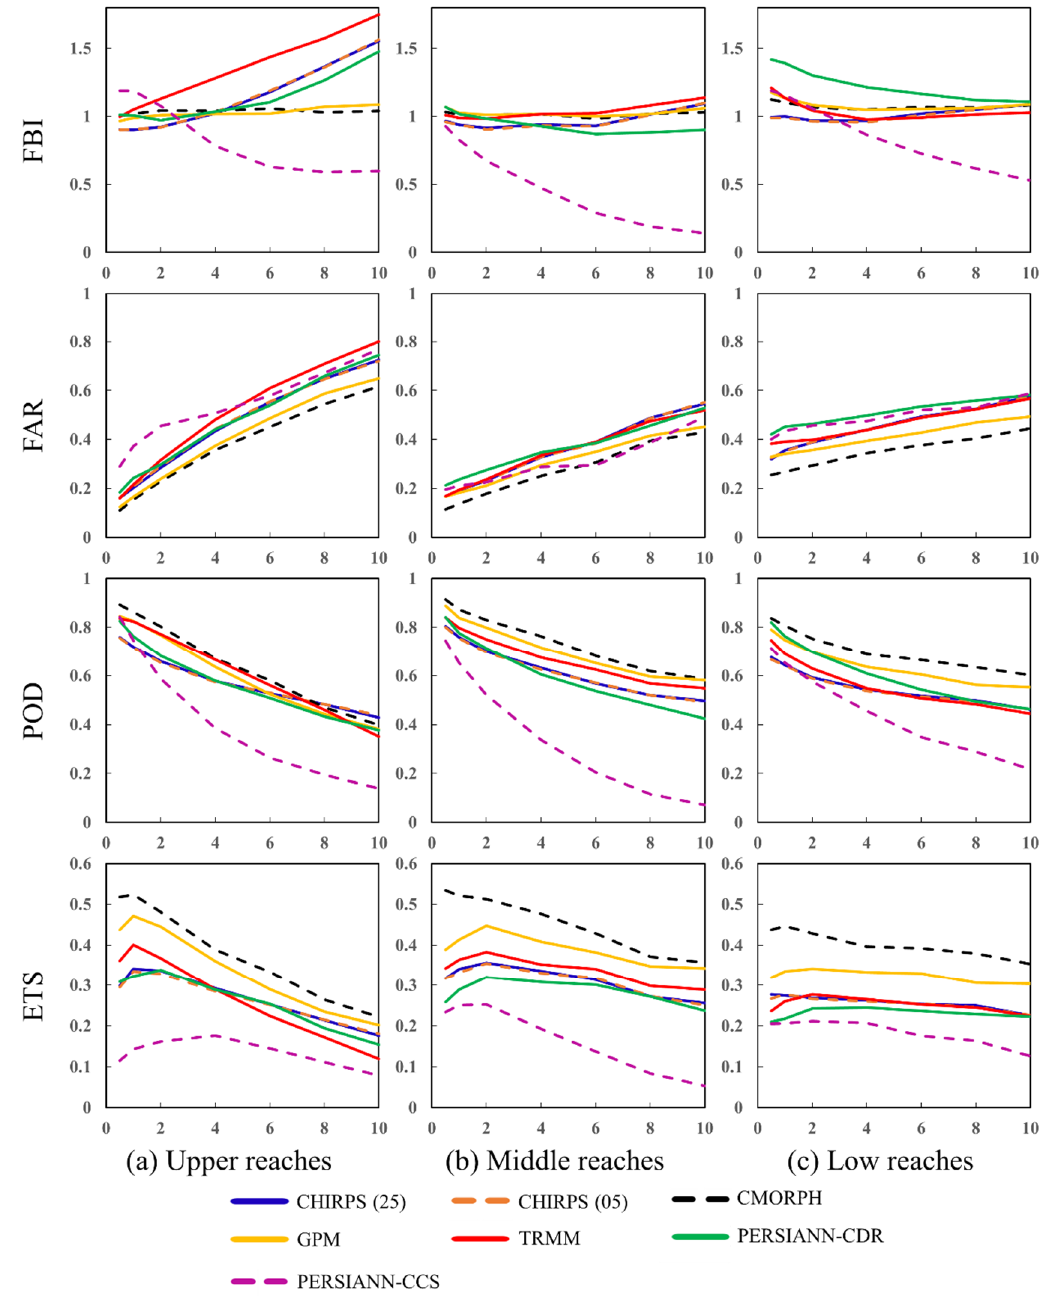
Figure 4. Skill scores ( FBI , POD , ETS , FAR ) of seven SPPs for storm thresholds ranging from 0.5 to 10 10 mm.